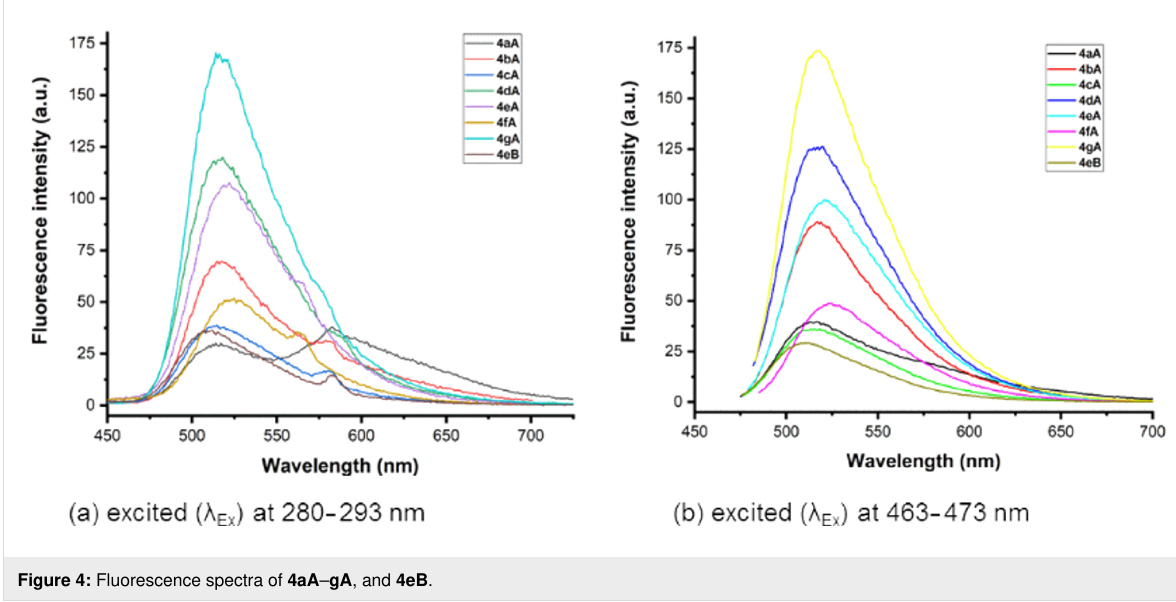
Figure 4: Fluorescence spectra of 4aA – gA , and 4eB .